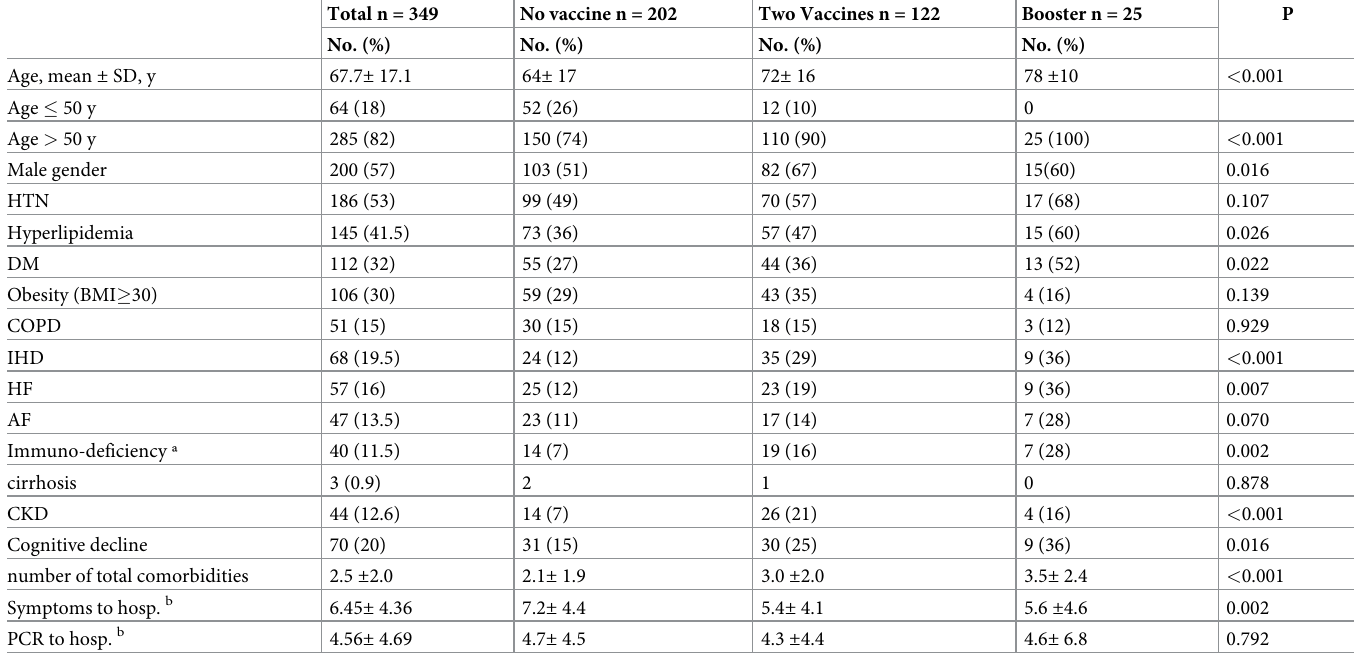
Table 1. Baseline characteristics of hospitalized severe or critical COVID-19 patients by vaccine